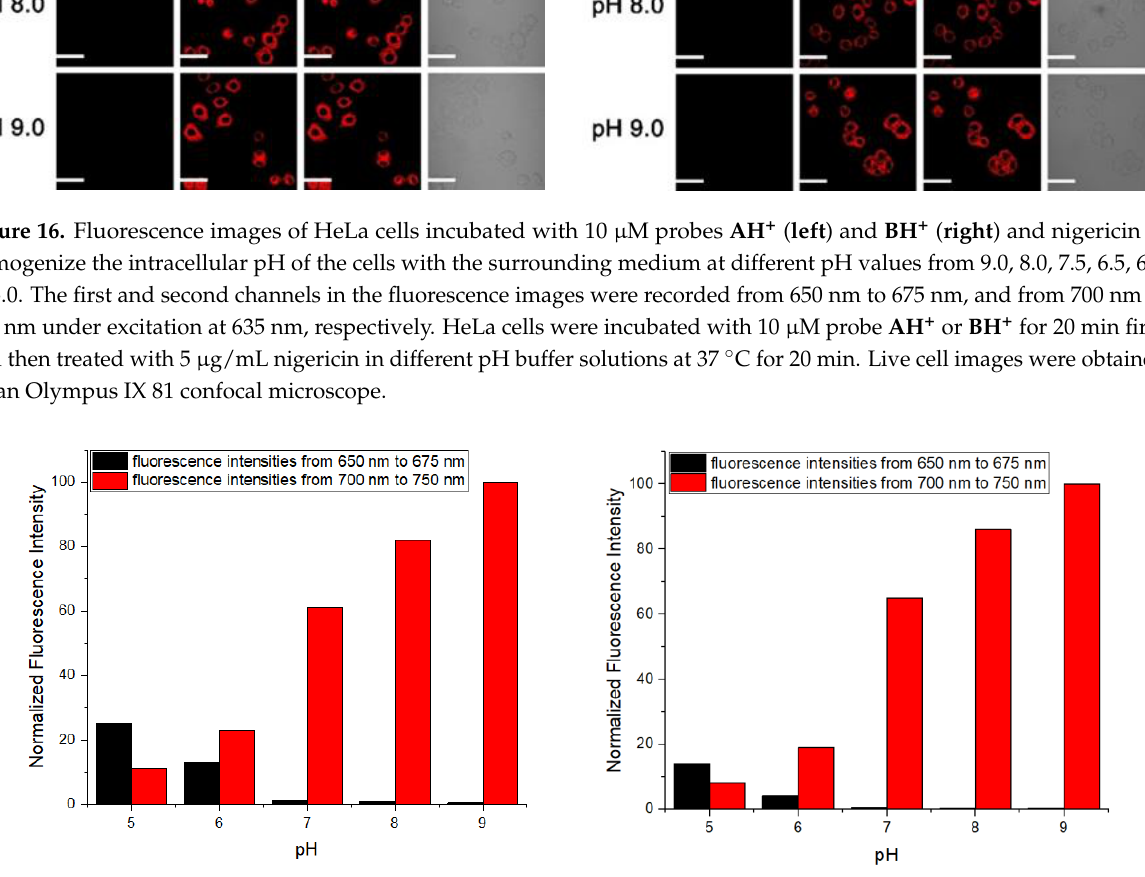
Figure 17. Fluorescence intensity of HeLa cells incubated with probes AH + ( left ) and BH + ( right ) obtained from Figure 16.